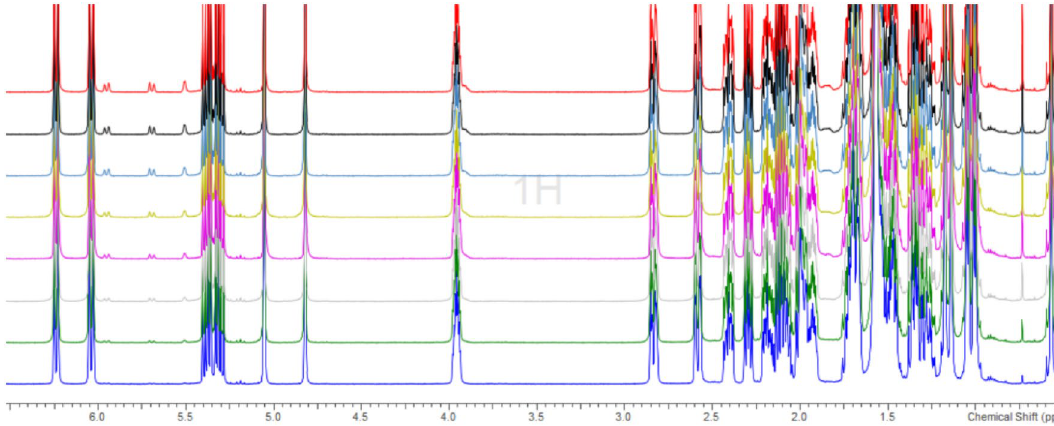
Figure 2. Overlay of 8 measurements at intervals of 8 h, for 25-hydroxyvitamin D2